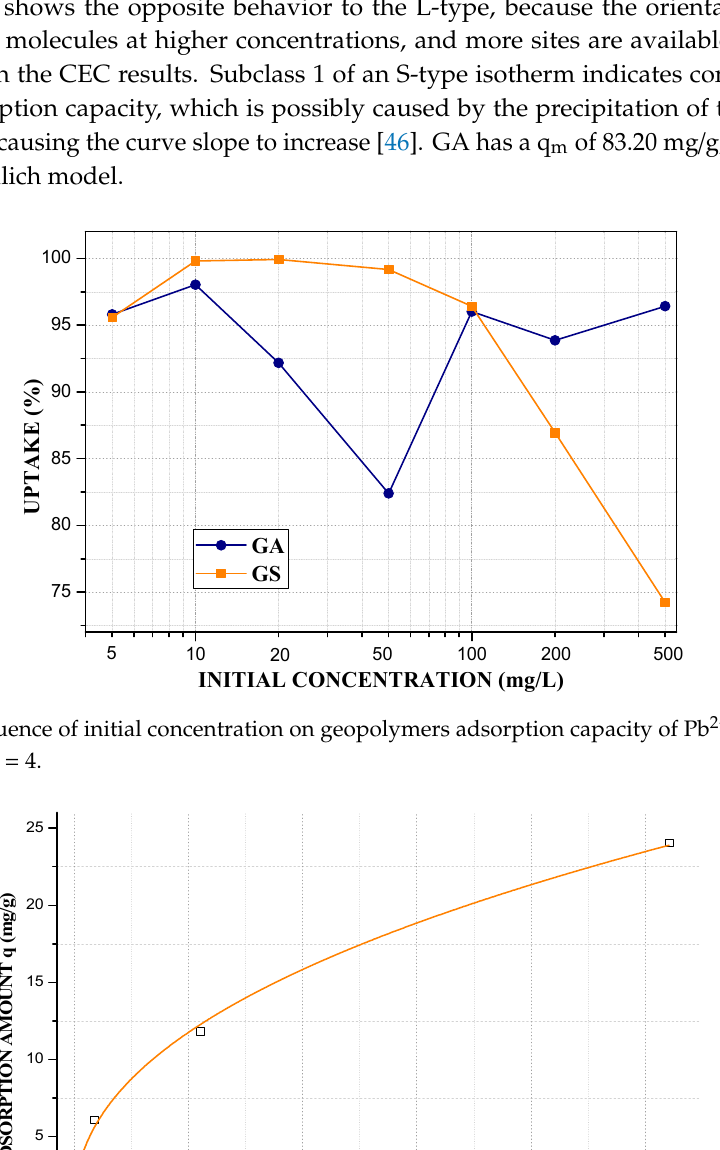
Figure 11. Langmuir–Freundlich Adsorption isotherm of GS: m = 0.15 g, V = 40 mL, pH = 4.